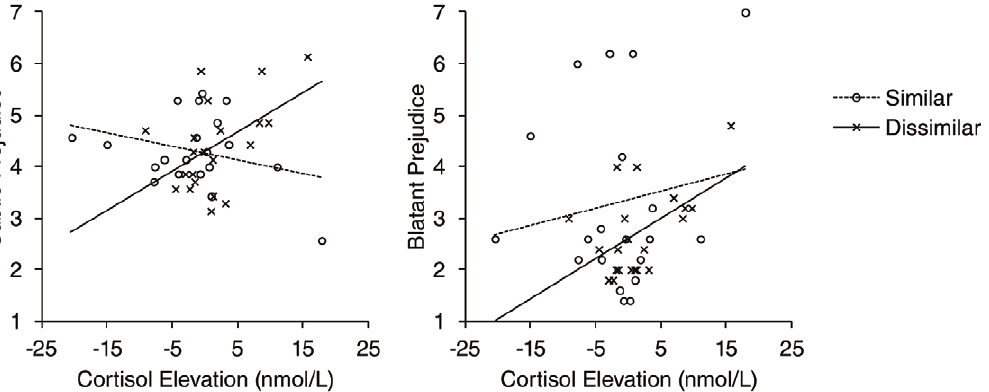
Figure 1. Subtle and blatant prejudice as a function of cortisol elevation. Lines indicate the direction of the relation between cortisol and self-reported prejudice. In both panels, solid lines represent the statistically reliable relation between cortisol (due to an anticipated interaction with an out-group member dissimilar to the self), and subtle and blatant prejudice, respectively.